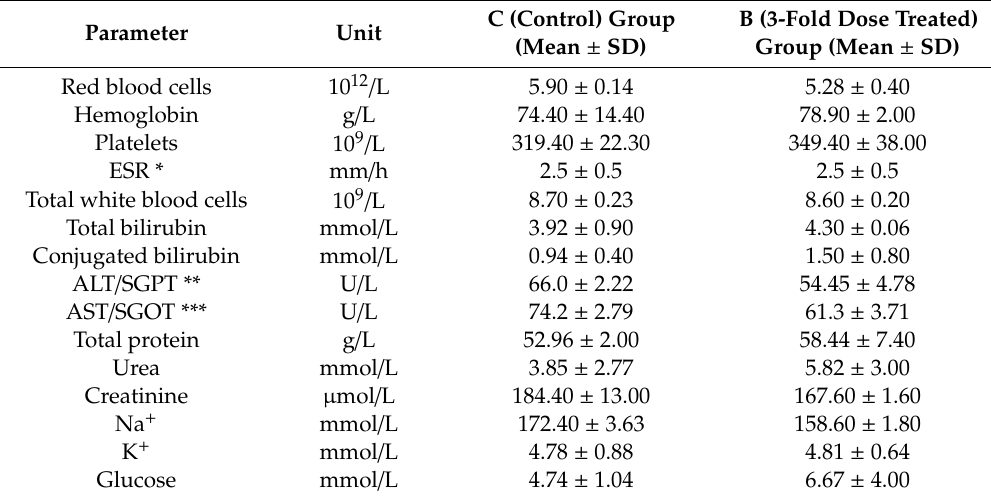
Table 1. Results from the hematological and biochemical analysis at the completion of the administration of the three-fold dose of Cyclamen extract ( n =